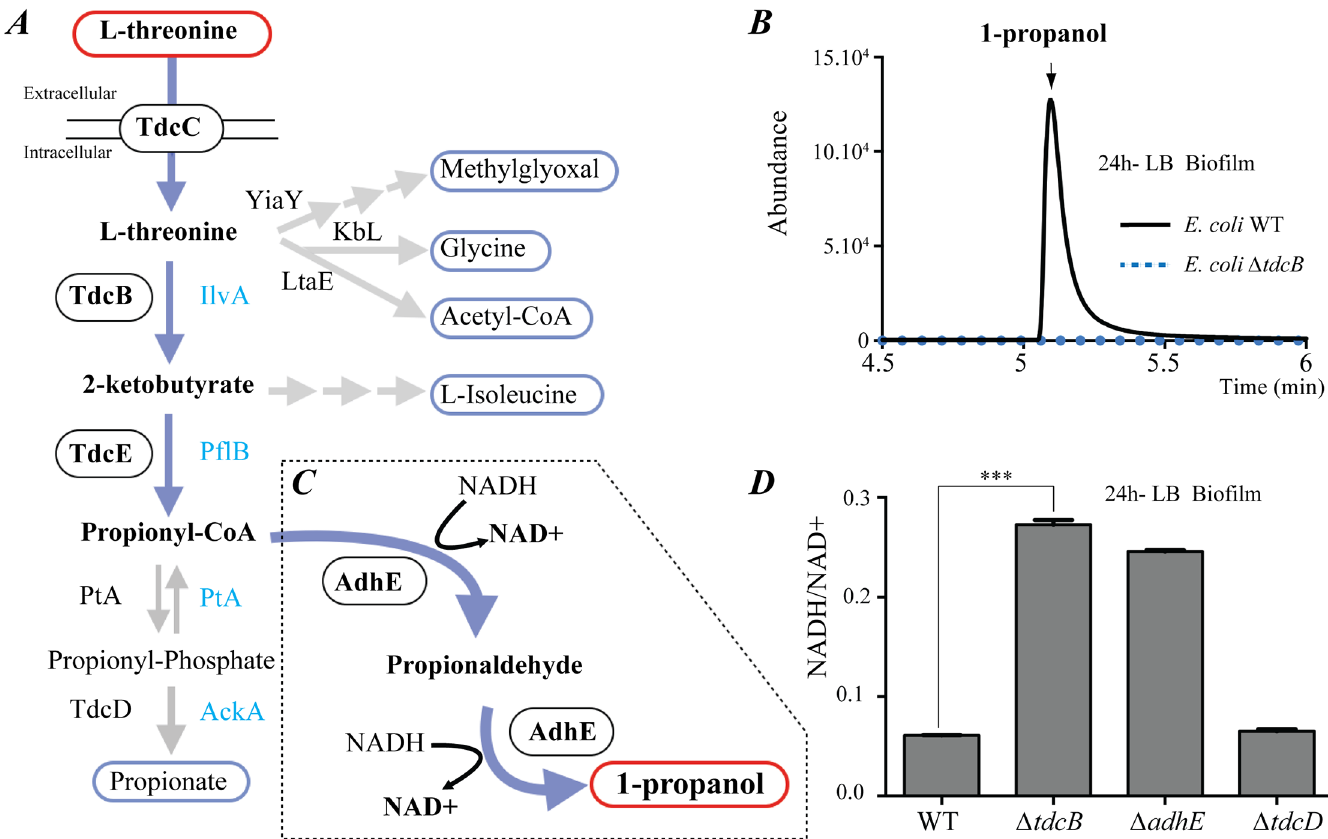
Fig 4. The TdcB- and AdhE-dependent 1-propanol pathway impacts E . coli redox balance. (A) Known E . coli threoninedegradationpathways and their end products. Enzymes involvedin the first steps of these pathways are indicated. Aerobic (blue) and anaerobic(black) threonineto propionate degradationpathway. Circled enzymes are essentialfor WT 1-propanol production. Due to its limited biofilm capacity, ability to produce1-propanol of the Δ tdcE mutant was only tested in anaerobicplanktonicconditions. ( B ) HS-SPME/GC-MS analysisof 1-propanol emitted from E . coli WT and Δ tdcB mutant biofilms formed in LB medium. ( C ) Dotted box: new E . coli adhE -dependent fermentation pathwayof threonineinto 1-propanol. NAD: nicotinamide adenine dinucleotide. NADH: reducedNAD; NAD + : oxidizedNAD. ( D ) NADH/NAD + ratios for E . coli WT, Δ tdcB , Δ adhE and Δ tdcD mutants grown under biofilm conditions. Error bars represent standarddeviationsfrom triplicate